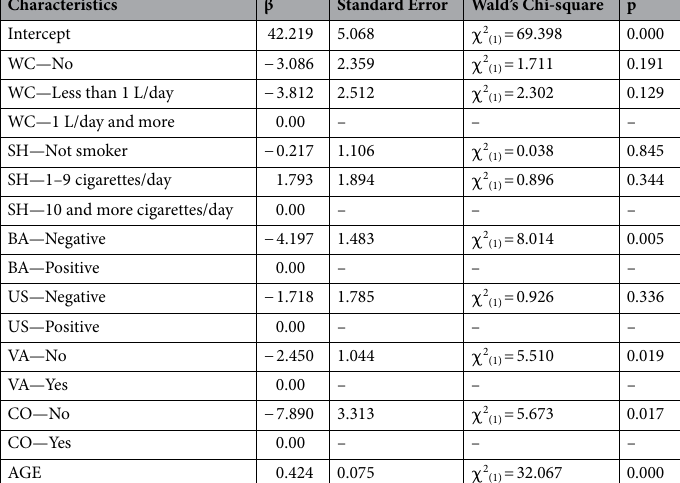
Table 8. Results of the generalized linear model with necrosis (NE) as response variable. WC wine consumption, SH smoking habit, BA semen bacteriological analysis, US urethral swab, VA varicocele, CO